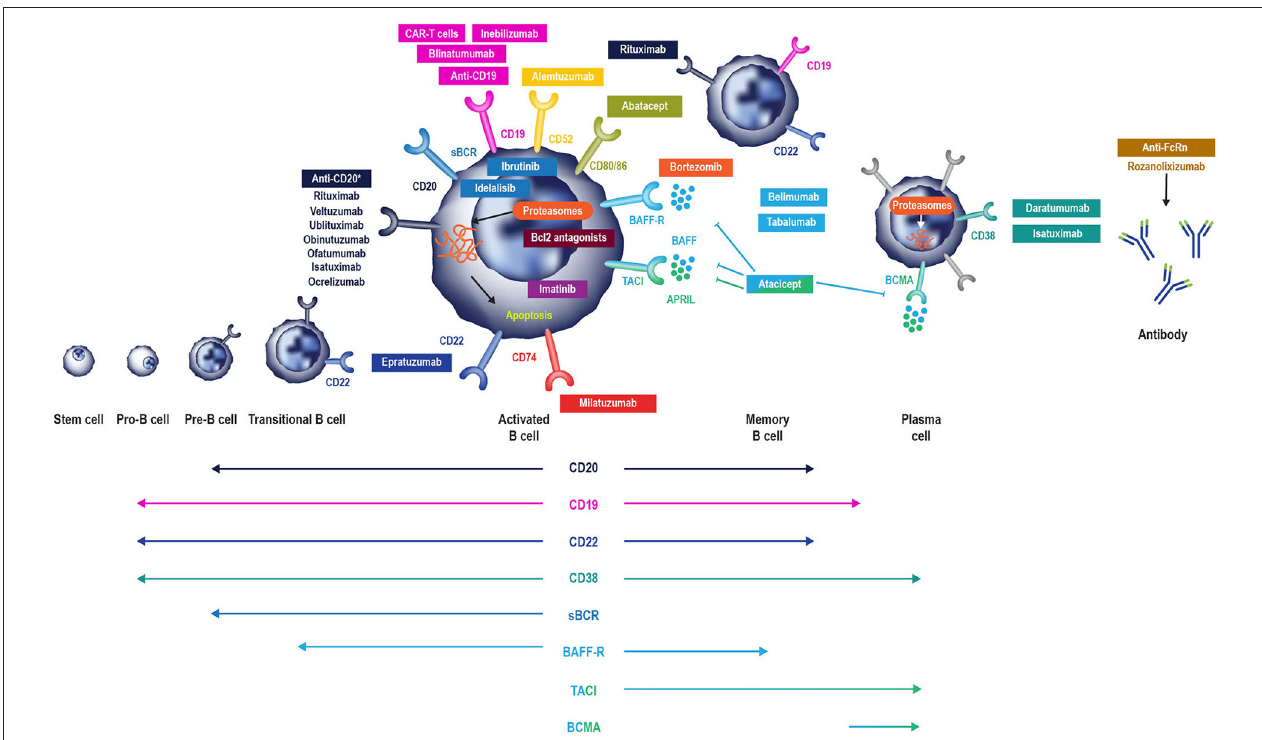
FIGURE 2 | B cell-specific chemotherapeutic causes of secondary antibody deficiency. Reproduced with the permission of the copyright holder The Royal College of Physicians (2). *Anti-CD20 compounds conjugated to other drugs are also in development. APRIL, a proliferation inducing ligand; BAFF(-R), B-cell activating factor (receptor); Bcl2, B cell lymphoma 2; BCMA, B-cell maturation antigen; (s)BCR, (surface) B cell receptor; TACI, transmembrane activator, and calcium